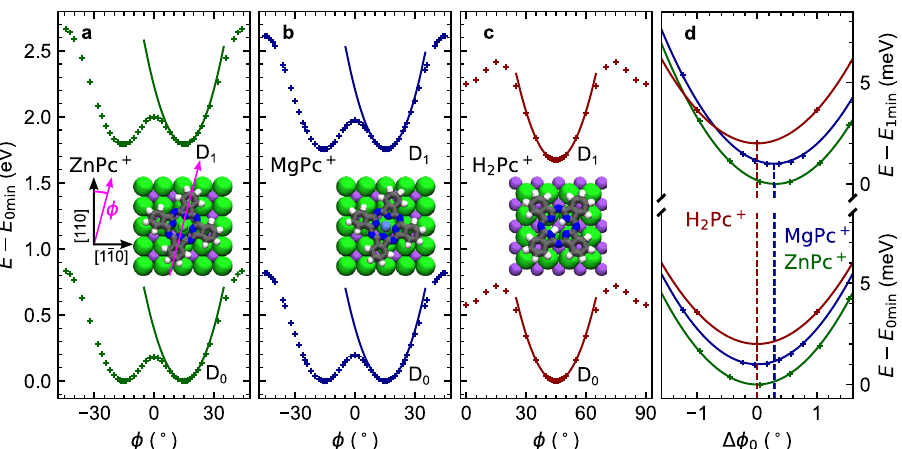
Fig. 2 | TD-DFT evaluation of the potential energy landscape for rotation of phthalocyanines on NaCl. a ZnPc + , b MgPc + and c H 2 Pc + total energy (relative to the energy of the minima E 0min )asafunctionofrotationbyangle ϕ forthe ground and excited states. The computed energy is plotted with crosses and the corre- sponding parabolic fi ts around the local minima with solid lines. The insets show the schematic models of the respective ground state cations in their equilibrium positions. The angle ϕ is de fi ned as between the molecule x-axes (crossing two opposing isoindole groups along N – N atom direction) and the nearest of the [110]